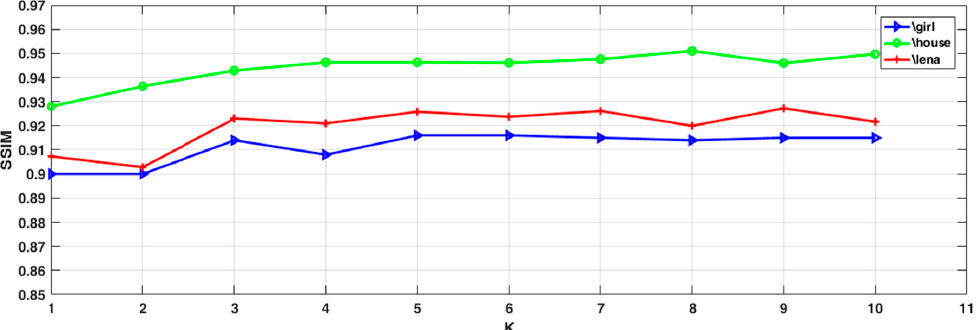
Figure 5. Comparison of structural similarity (SSIM) under different K values (Noise Level = 30%). The test images (“Girl”, “House”, ”Lena”) are corrupted by 30% impulse noise.